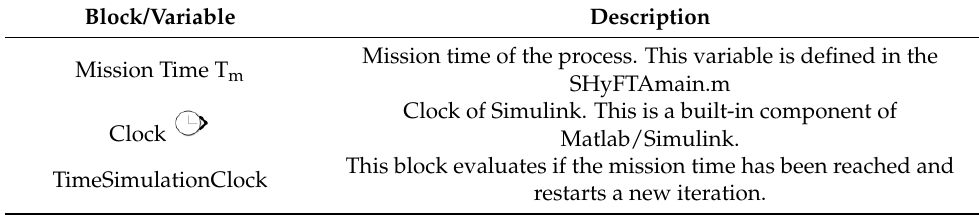
Table 1. Main elements of the “iter evolution” block.